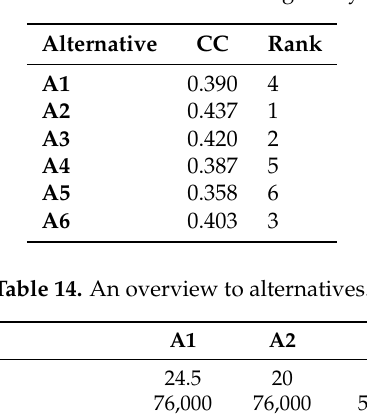
Table 13. Closeness coefficient and ranking of dry bulk carriers.